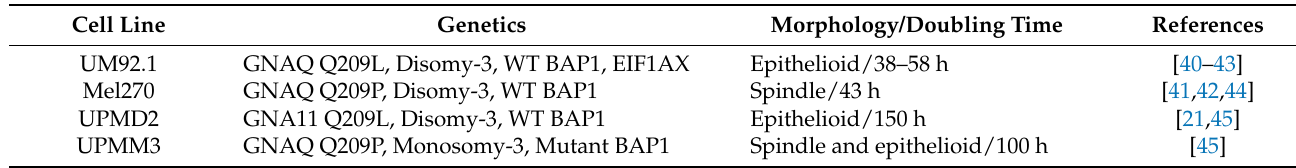
Table 1. Characteristics of uveal melanoma cell